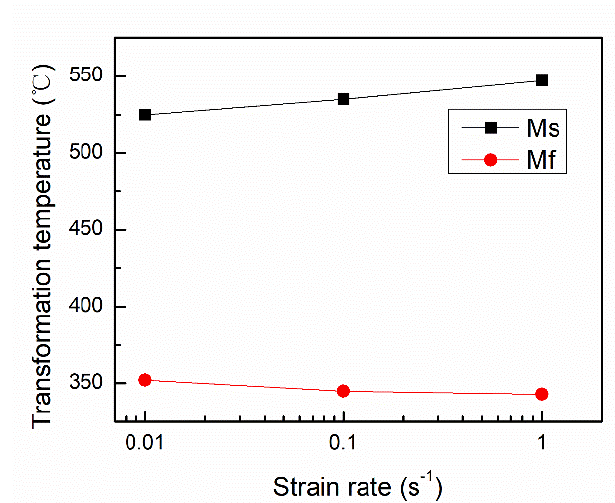
Figure 18. Phase transformation temperatures for the low-carbon ferritic stainless steel samples with the different strain rates.